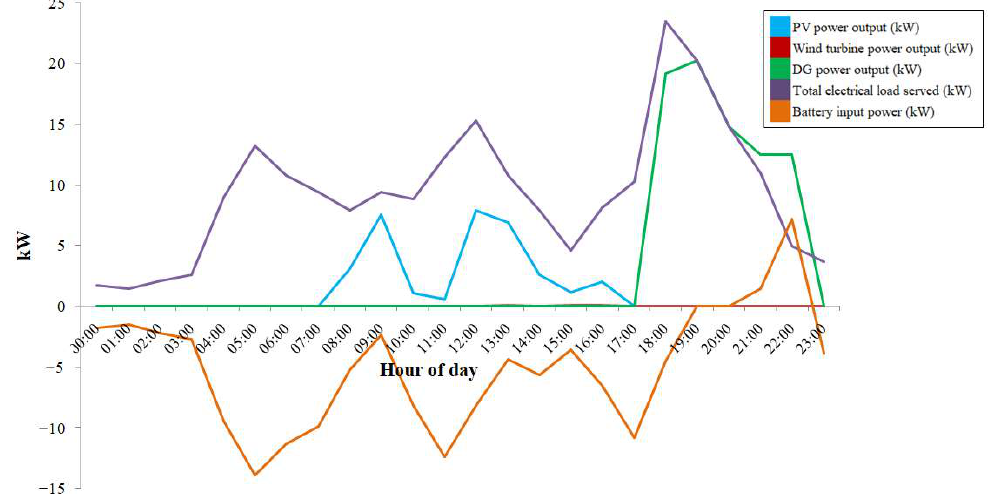
Figure 20. Time series power output trend of PV-Wind-BSS-DG configuration for 1st January.